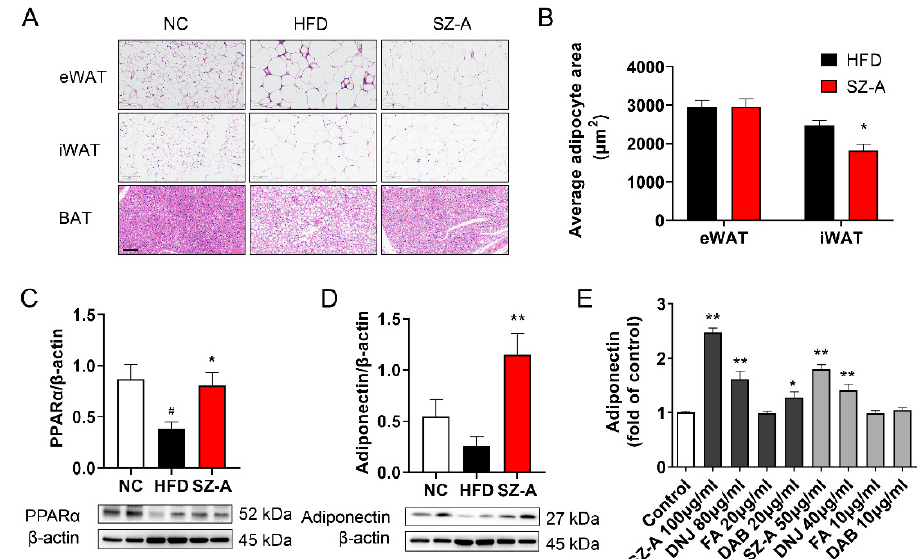
Figure 2. Effect of SZ-A on adipose tissues and adipocytes. ( A ) Representative H&E staining of dissected tissues. Scale bar, 100 µ m. ( B ) Quantification of eWAT and iWAT adipocyte area. ( C , D ) Protein expressions of PPAR α and adiponectin in iWAT ( n = 4~6/group). Data are represented as mean ± SEM. # p < 0.05 compared with the NC mice (i.g.), and * p < 0.05, ** p < 0.01 compared with the HFD mice (i.g.). The protein amount of adiponectin (E) in the cell supernatant was determined by ELISA ( n = 3). * p < 0.05, ** p < 0.01 compared with the corresponding control group. iWAT, inguinal adipose tissue; eWAT, epididymal adipose tissue; BAT, brown adipose tissue; NC, normal control; HFD; HFD, high-fat diet; SZ-A, Ramulus Mori (Sangzhi) alkaloids; PPARα, proliferator-activated receptor-α.